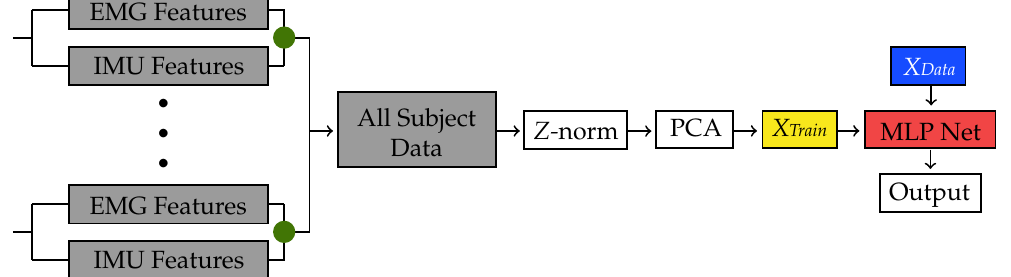
Figure 9. Training flow for the classification methods during each cross-validation iteration using both EMG and IMU data. A similar procedure was used for the EMG only dataset. Fused EMG and IMU data from Subject S 1 to Subject S k in the iteration training folds (gray) are stacked together to form a unique dataset, which is then normalized and reduced to form X Train (yellow). X Train is then used to train a MLP network (red), which then classifies X Data from Subject S n . The green dots represent a feature-level